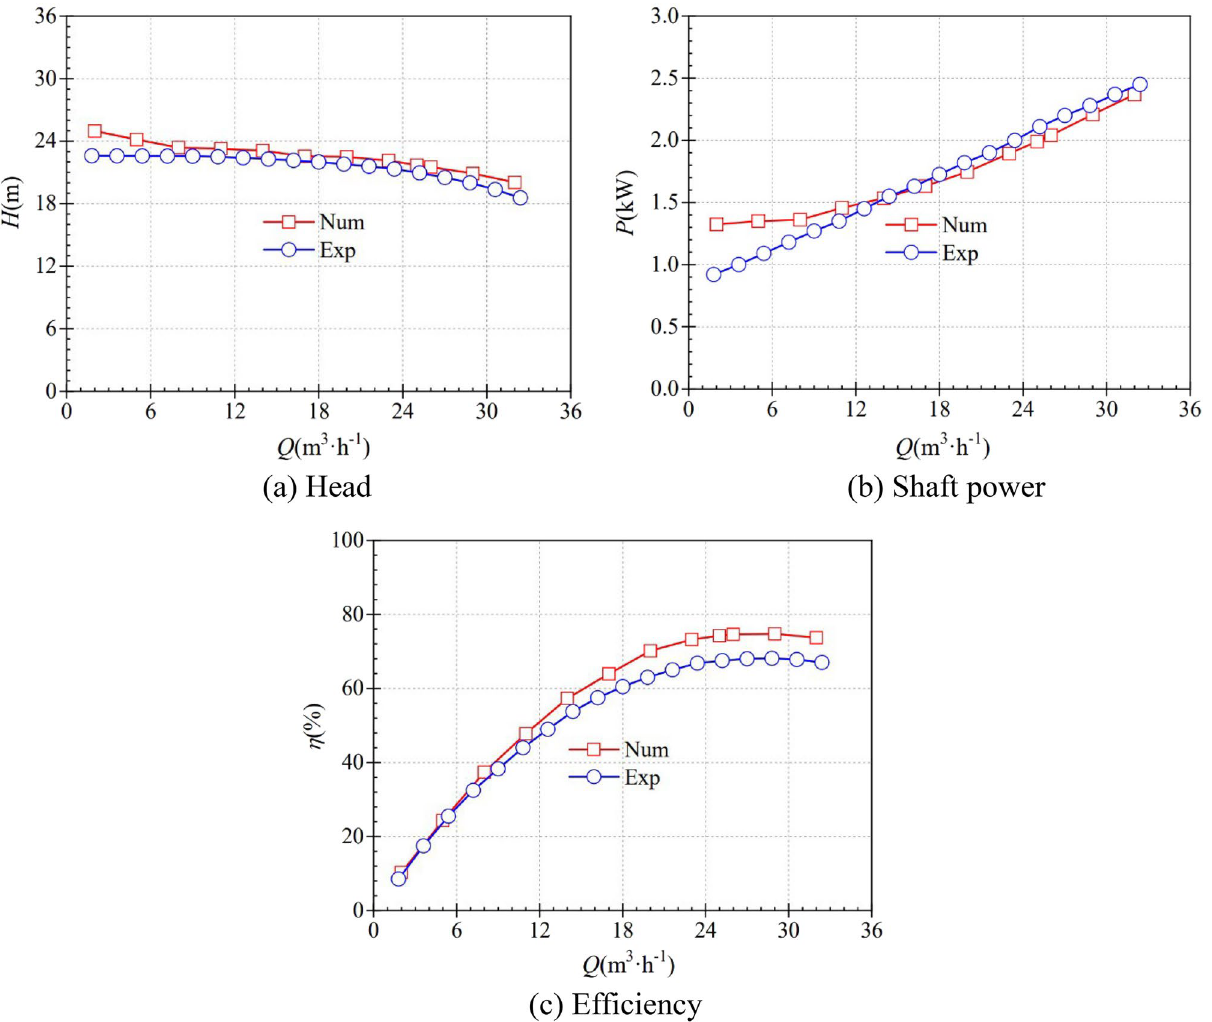
Figure 6. Comparison of external characteristics. ( a ) Head, ( b ) Shaft power, ( c )